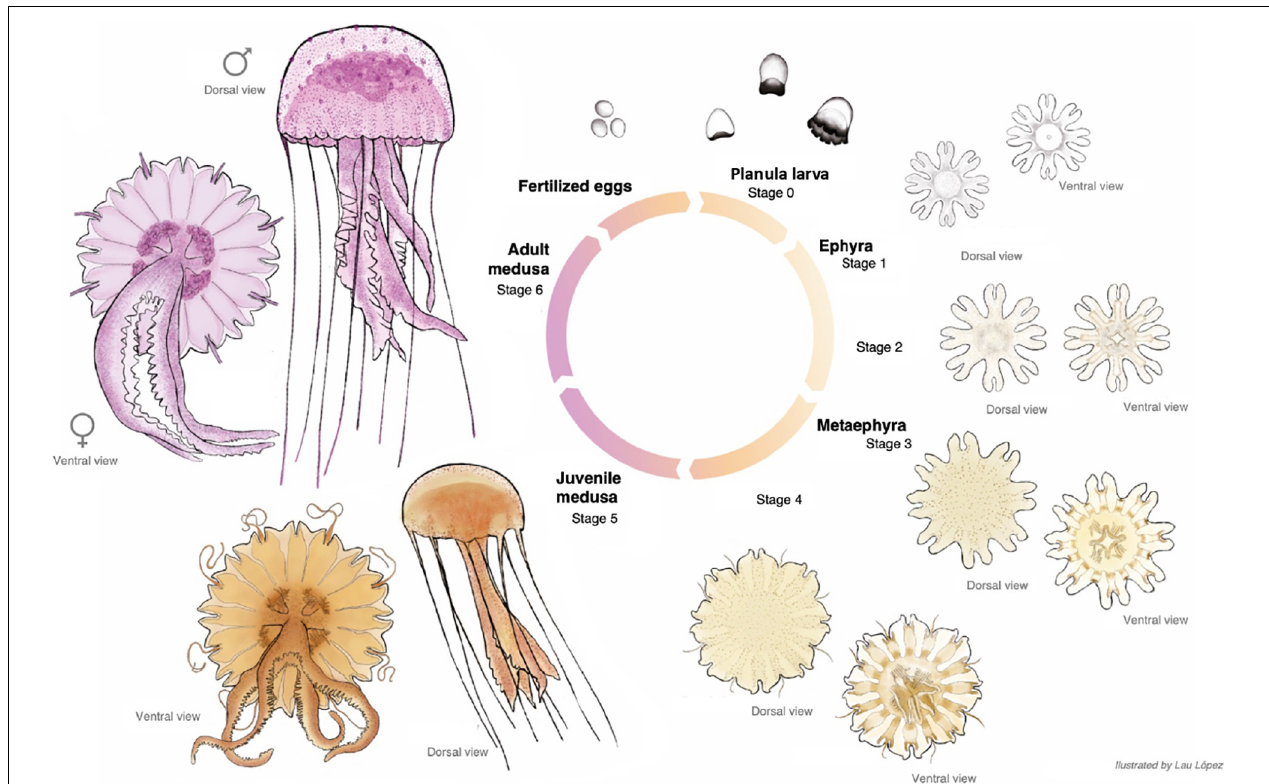
FIGURE 8 | Pelagia noctiluca life cycle. Illustrated by Lau López .